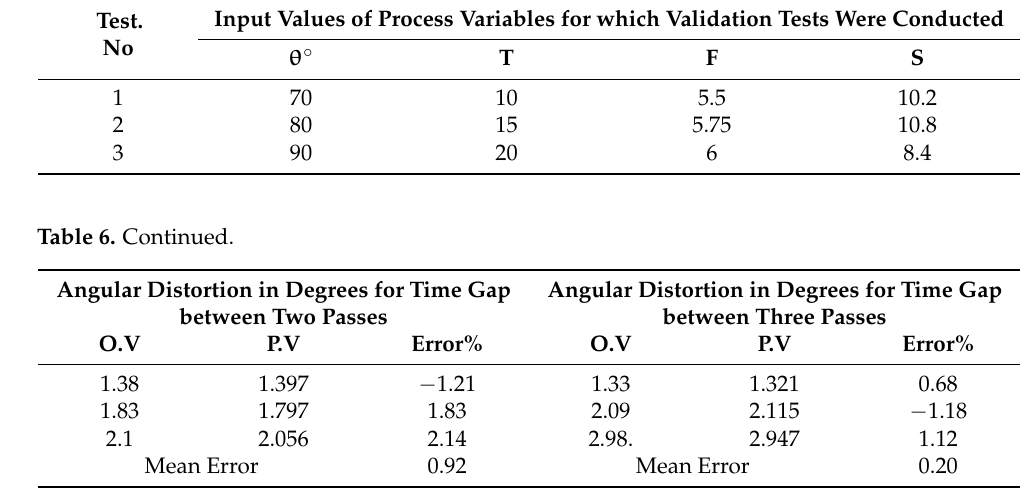
Table 5. Results of Validation